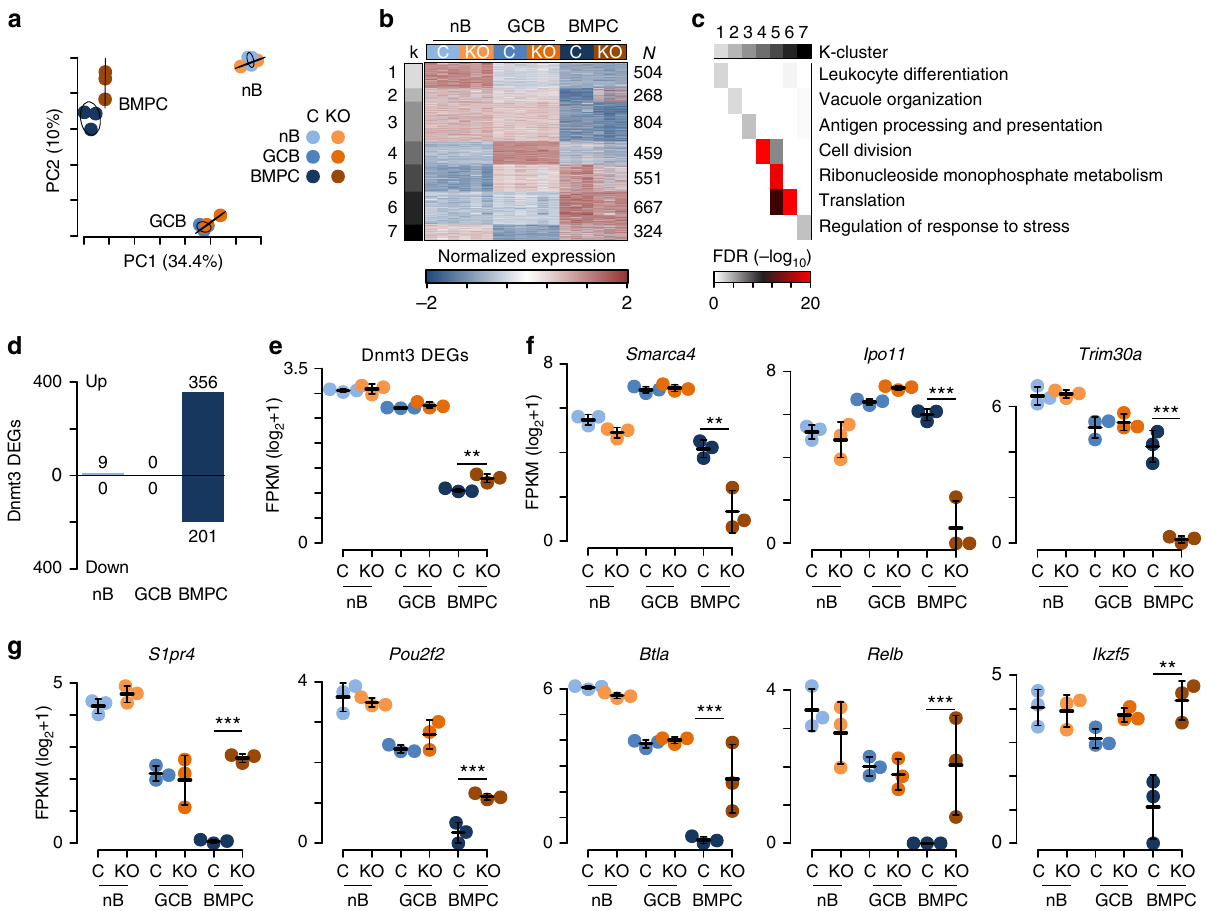
Fig. 3 Dysregulation of plasma cell gene expression without Dnmt3a and Dnmt3b. a Principle component analysis of gene expression. The percentage in parenthesis is the proportion of variation explained by each component and 95% con fi dence intervals for each group are drawn. b K-means clustering of differentially expressed genes organized into seven categories uniquely. Samples are represented by columns and genes by rows. c Gene ontology analysis of genes contained in the K-clusters from b . Select ontologies are shown, and the signi fi cance of each ontology in each K-cluster (represented by columns) is denoted by color. d Number of Dnmt3-speci fi c differentially expressed genes (DEGs) found between Dnmt3-suf fi cient and -de fi cient naive B cells (nB), germinal center B cells (GCB), and bone marrow plasma cells (BMPC). Genes upregulated in Dnmt3-de fi cient cells are shown above and those downregulated are shown below. e Average level of expression of all Dnmt3-speci fi c differentially expressed genes shown in d . ( f , g ) Examples of Dnmt3 differentially expressed genes both downregulated ( f ) and upregulated ( g ) in Dnmt3-de fi cient BMPC. **FDR ≤ 0.01, ***FDR ≤ 0.001; mean and standard defviation are shown f , g . Data are from 3 experiments and 24 mice where nB were isolated from 6 mice, GCB were from 12 mice (2 mice were pooled per sample), and BMPC were from 6 mice. Each cell type contained 4 female and 2 male (nB, GCB) or 4 male and 2 female (BMPC) mice split evenly between the genotypes. Differentially expressed genes had an FDR ≤ 0.01 and a fold change